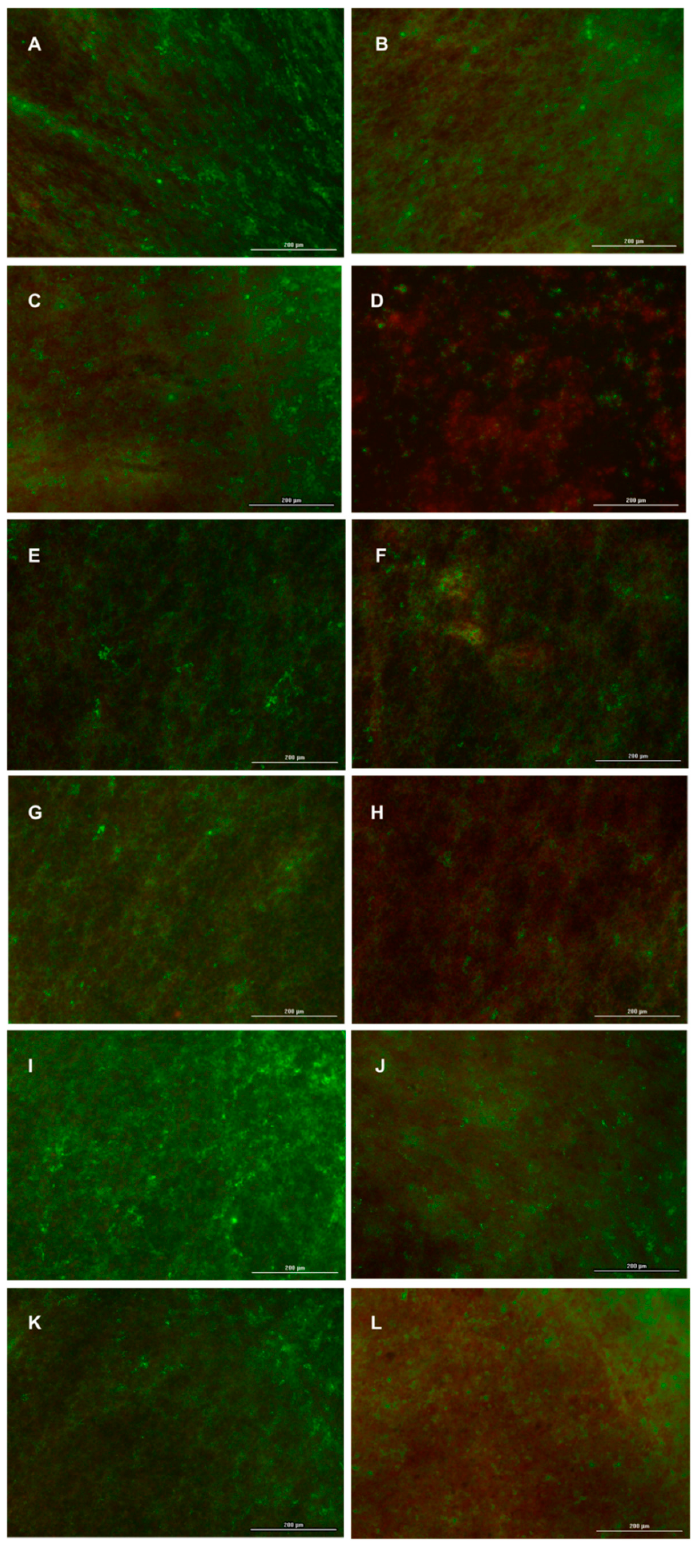
Figure 10. Fluorescent microscopy images of live / dead staining of ( A – D ) S. mutans , ( E – H ) PAO1, and ( I – L ) S. mutans / PAO1 on ( A , E , I ) PLA, ( C , G , K ) PLA-RSV1, and ( D , H , L ) PLA-RSV2. RSV was used as positive control ( B , F , J ). Live bacteria were stained green, and dead bacteria were stained red. Live and dead bacteria in proximity resulted in yellow / orange color .